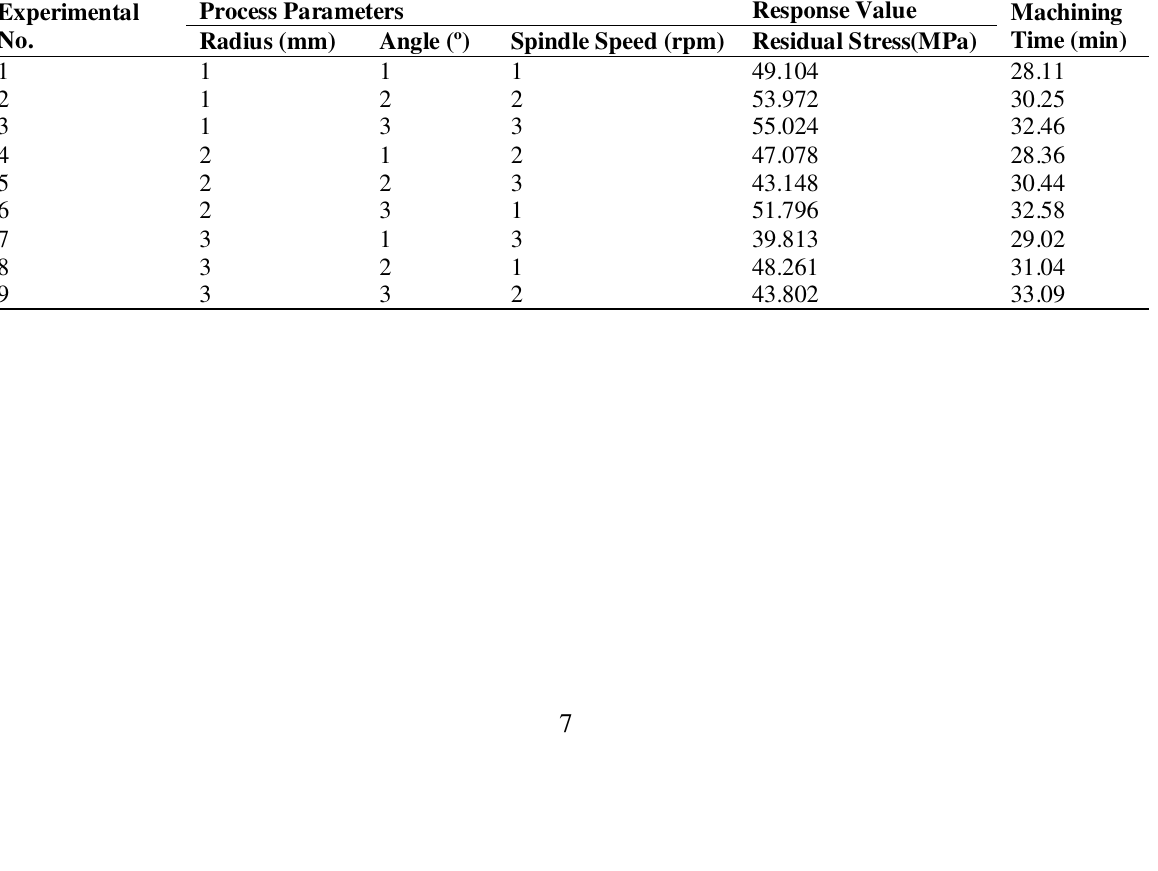
Experimental layout using L9 orthogonal array and corresponding results for the flat tool.